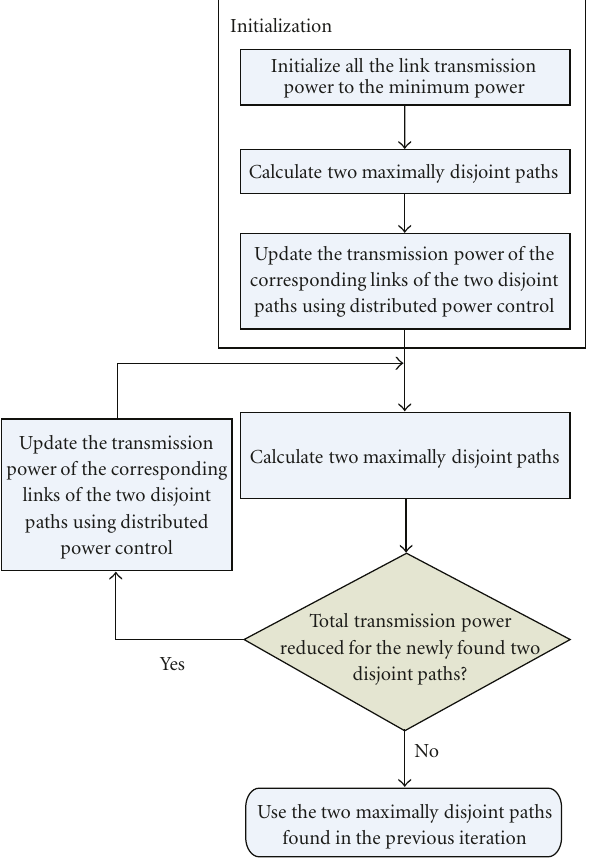
Figure 4: An iterative algorithm for joint power control and maxi- mally disjoint